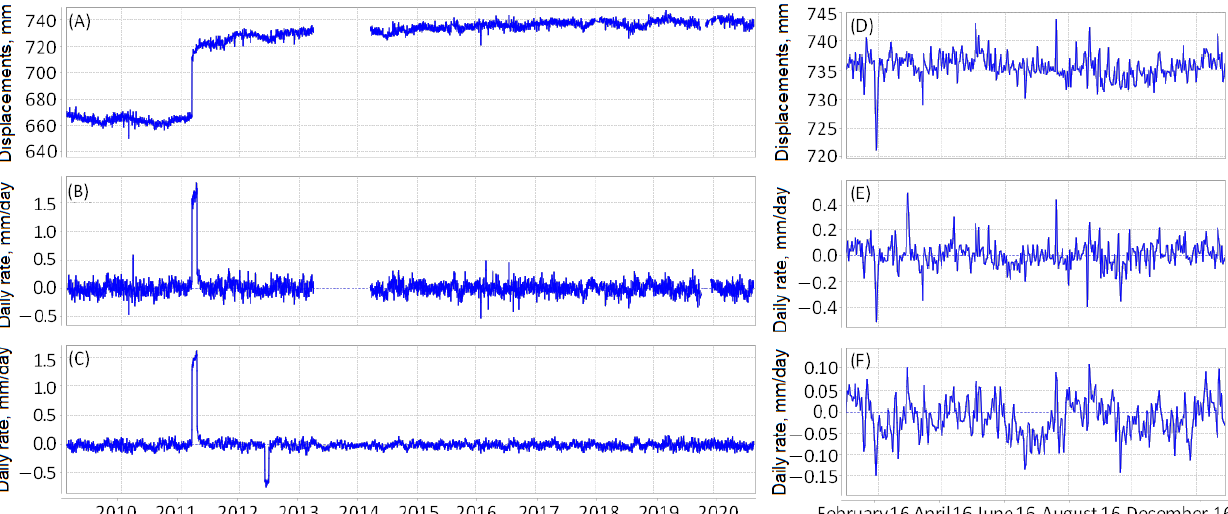
Figure 5. Time series of displacements in the N–S direction of the Japanese receiving station at 35.45 ◦ N and 139.2 ◦ E. ( Left ) Interval 1 January 2009–26 July 2020. ( Right ) Interval 1 January 2016–14 December 2016. ( A , D ) time series of coordinates y ( t ) of the station (mm); ( B , E ) time series of daily rates g yk ( t ) of the station (mm/day); ( C , F ) time series V yn ( t ) at the point n of the field V y